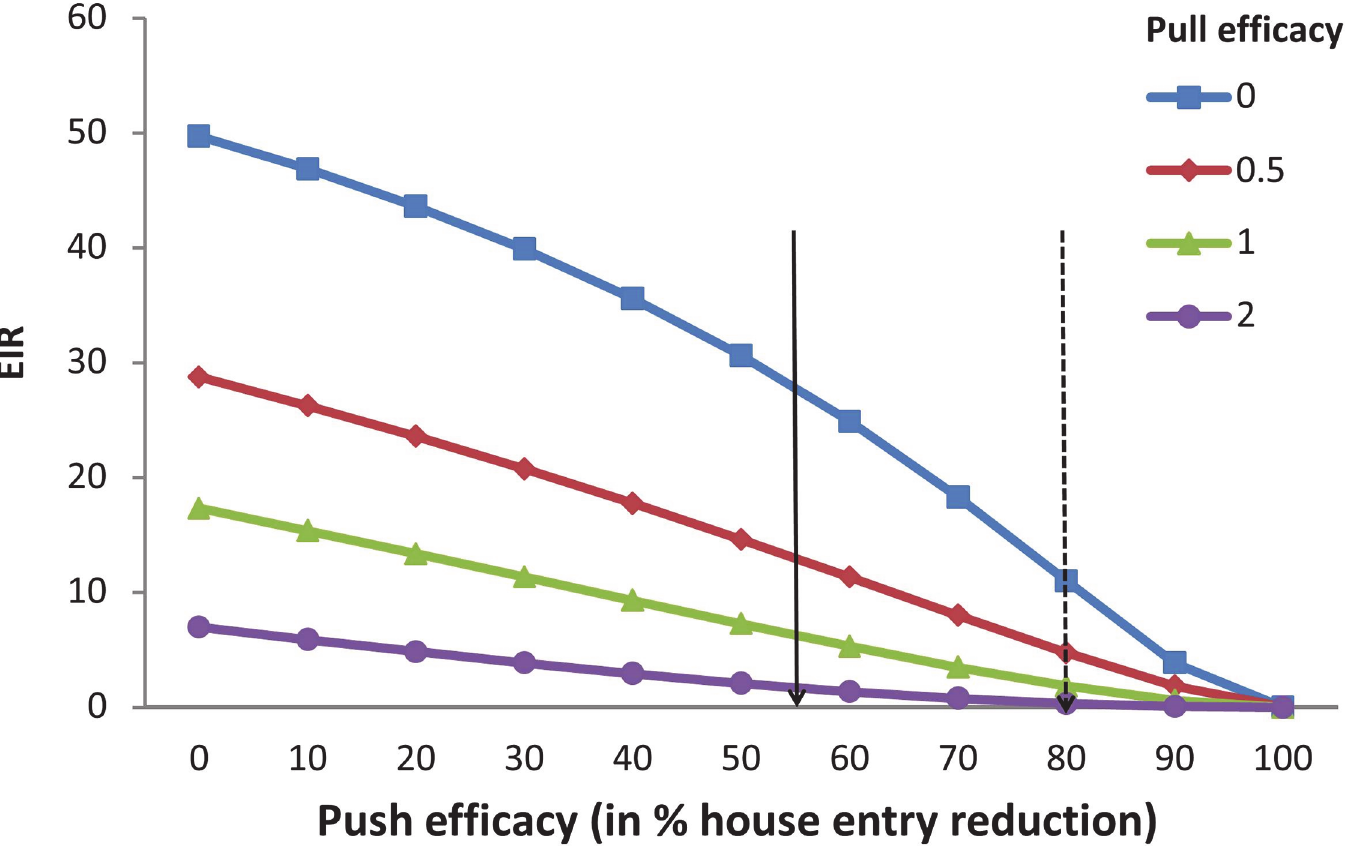
Fig 5. Model simulations of a scenario in which mosquitoes are highly resistant against insecticides. Shown is the entomological inoculation rate (EIR) as a function of different levels of push efficacy. Push efficacy is expressed as the percentage of house entry reduction and pull efficacy is expressed as the relative attractiveness of the trap, compared to a human